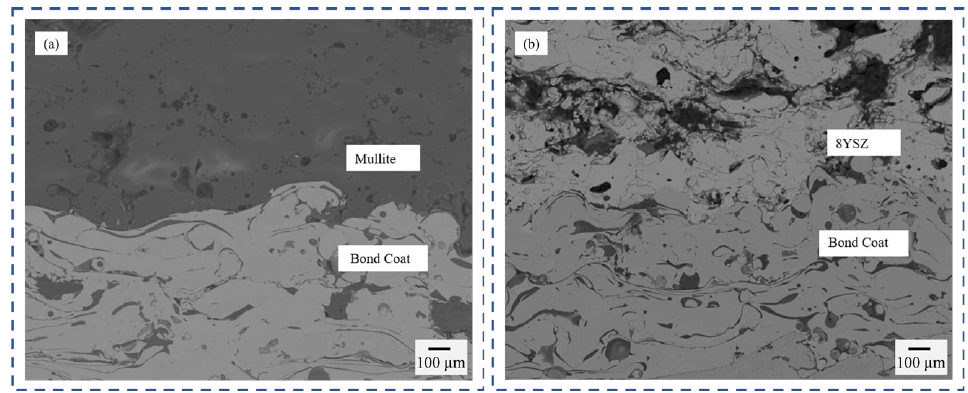
Figure 1. The scanning electron microscope picture of cross-sections of the coatings: ( a ) Mullite coating, ( b ) 8YPSZ coating [18].